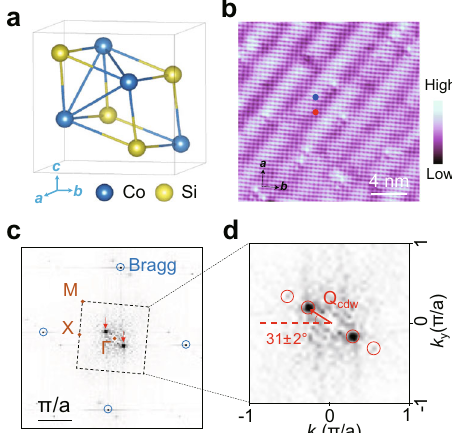
Fig. 1 Atomic structure, STM image and the FT images of the (001) surface of CoSi. a Crystalline structure of CoSi. b Large-scale STM image of CoSi (001) surface showing stripe-like modulations. The black arrows mark the crystalline symmetry directions. Scanning settings: V s = − 200 mV, I t = 0.4 nA. c Fourier transformed image of ( b ). The black dashed square outlines the 2D Brillouin zone of the surface. Bragg spots and high- symmetry points of the square lattice are outlined by blue circles and brown dots, respectively. Around the Г point, two sharp peaks associated with the stripe modulation can be differentiated, as highlighted by red arrows. d Zoom-in image of the 2D Brillouin zone. The red arrow marks the CDW wave vector Q cdw . The angle between Q cdw and k x direction is 31 ±